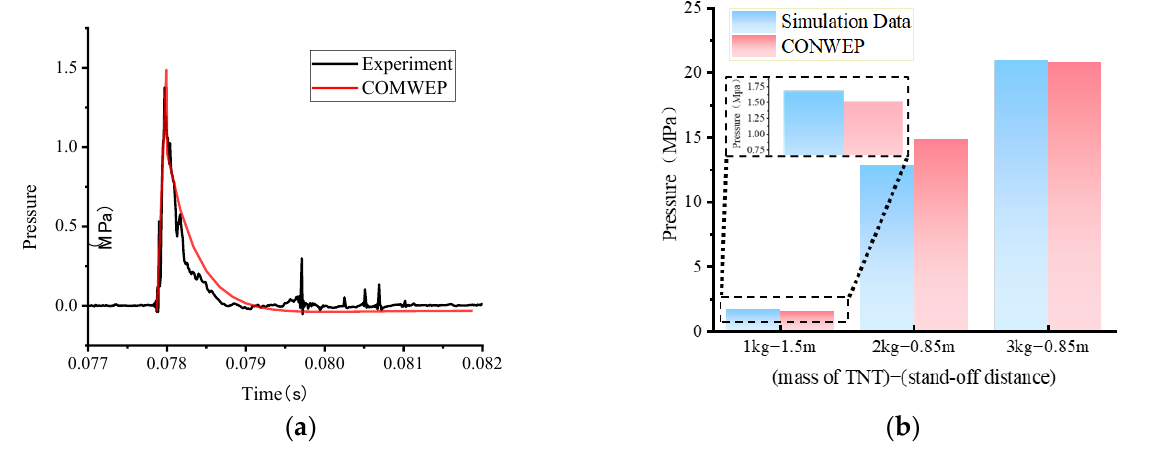
Figure 8. Reflected pressure in experiment, simulation, CONWEP. ( a ) Reflected pressure of the vault under blast load of 1 kg TNT with stand-off distance of 1.5 m. ( b ) Peak of pressure at the